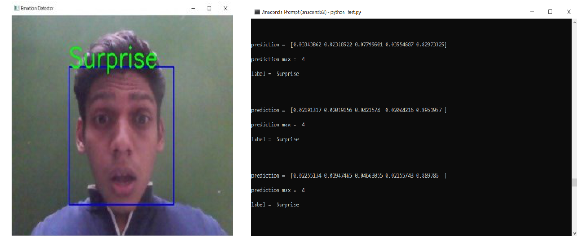
Fig 6. Prediction of Sad Emotion